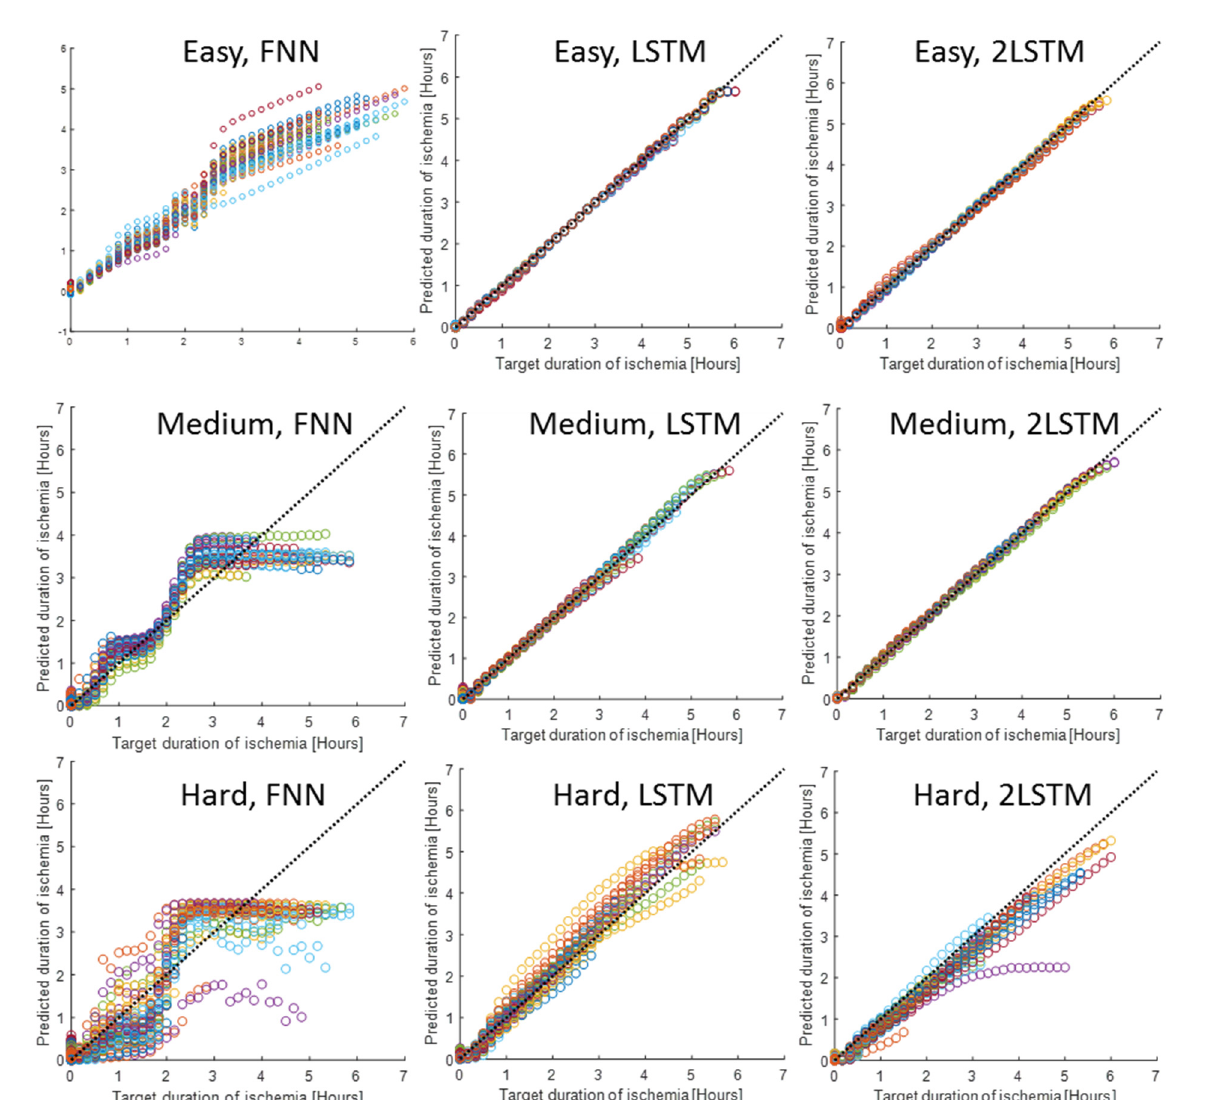
Figure 6. Predictions on 50 examples of liver ischemia and 50 controls from the test data for the different cases presented in table 2. Colors indicate different